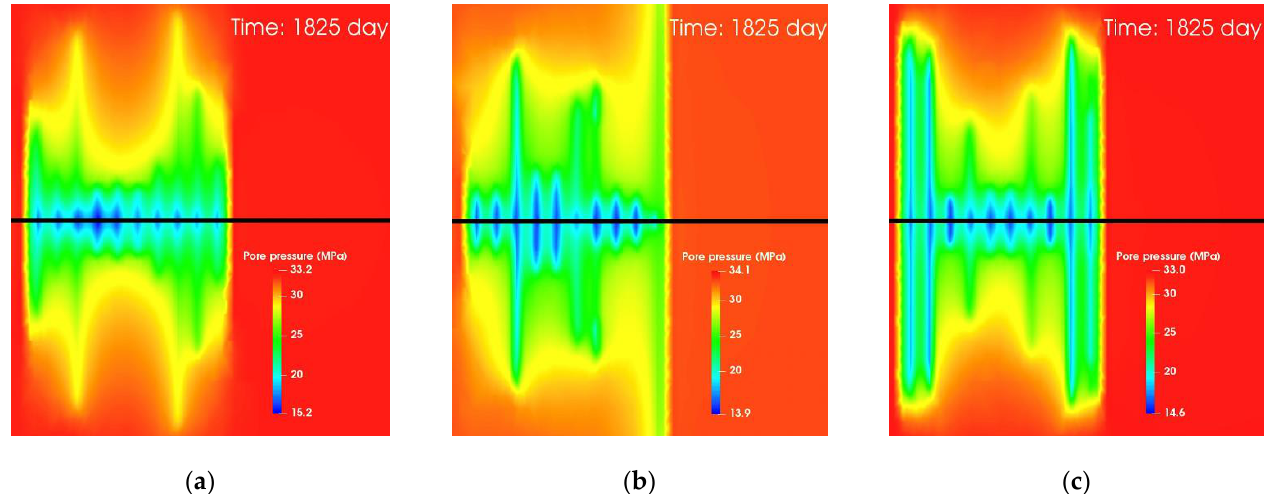
Figure 16. Pore pressure distribution on the horizontal plane through the wellbore at the end of the production period. ( a ) Case using slick water, ( b ) Case using NG foam, ( c ) Case using hybrid NG and NG foam.